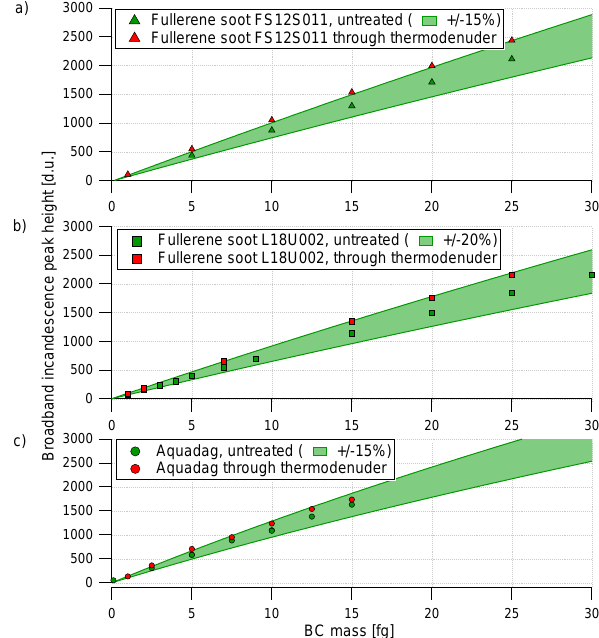
Fig. 6. Thermodenuder effect on SP2 calibration using commer- cially available products: measurement of the SP2 sensitivity with and without thermodenuder of (a) fullerene soot batch FS12S011, (b) fullerene soot batch L18U002, (c) Aquadag®